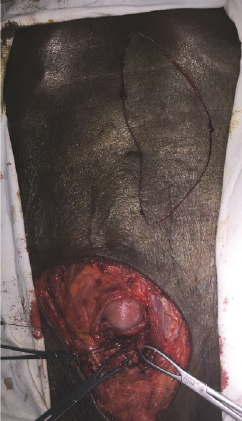
Figure 5: After the tumor resection, the skin incision lines to raise the flap are